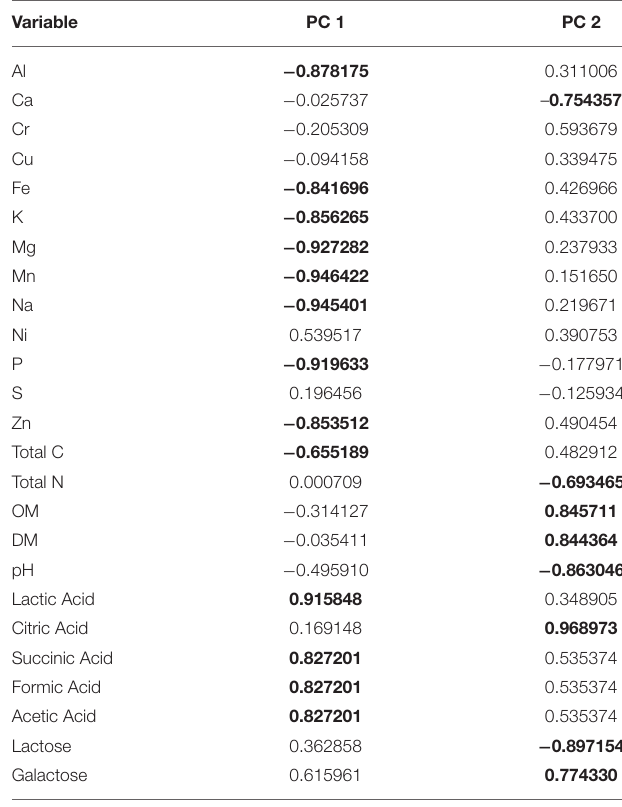
TABLE 4 | Principal component analysis (PCA): Principal component